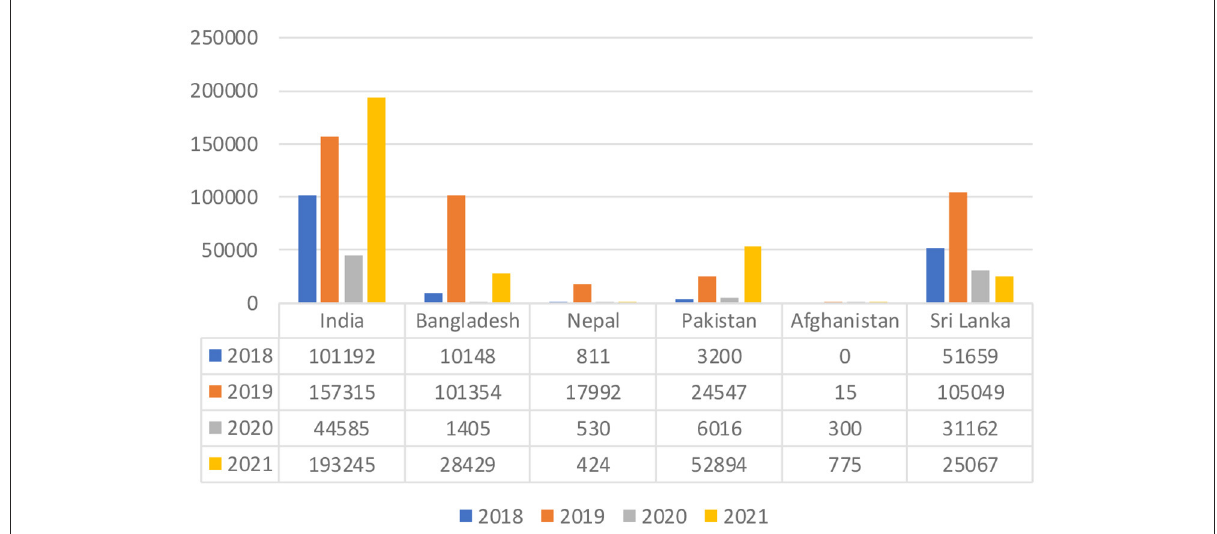
FIGURE1 Trend of dengue-confirmed cases in South Asian countries. Data Source: We have extracted the confirmed Dengue cases as reported by the official websites of the above countries